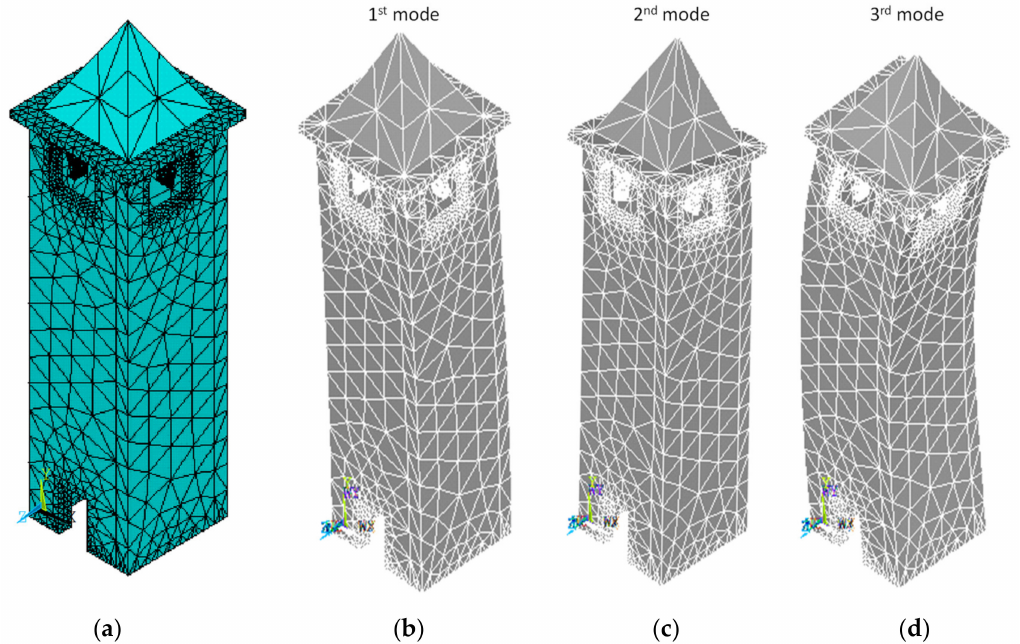
Figure 2. FE simulation of Vatopedi bell-tower: ( a ) meshing, ( b ) 1st modal shape, ( c ) 2nd modal shape, and ( d ) 3rd modal shape.